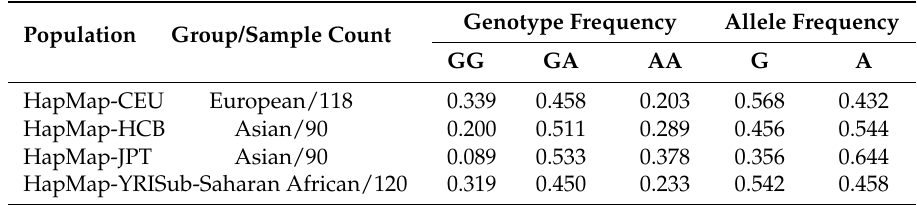
Table 1. Population diversity of PROK1 wild-type and V67I (c.199 G>A, rs7514102)